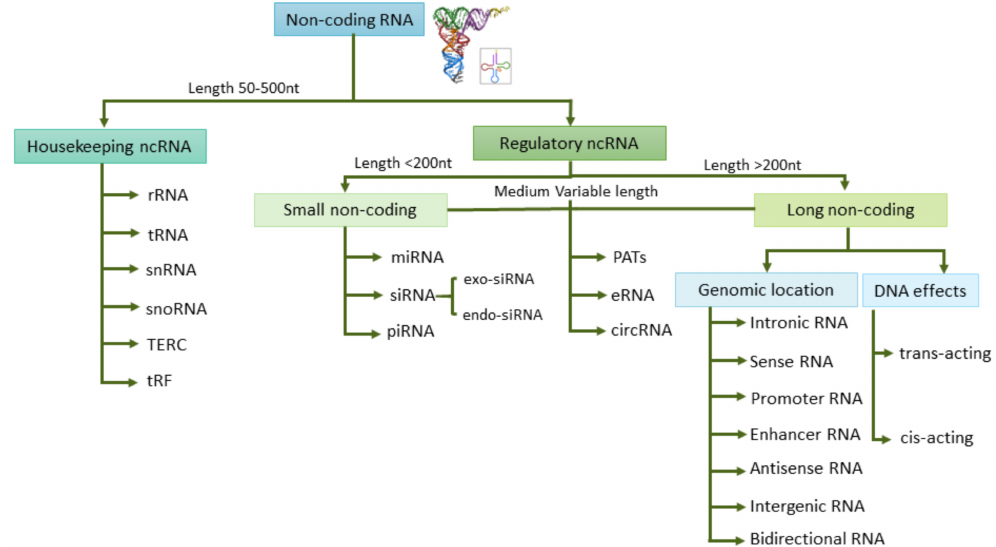
Figure 2. Non-coding (nc)RNAs classification into different groups based on their length and their regulatory roles. Small non coding RNA (sncRNA), long non coding RNA (lncRNA), ribosomal RNA (rRNA), transfer RNA (tRNA), small nuclear (snRNA), small nucleolar (snoRNA), telomerase RNA component (TERC), tRNA-Derived Fragments (tRF) and tRNA halves (tiRNA), microRNA (miRNA), small interfering RNA (siRNA), piwi-interacting RNA (piRNA), promoter-associated transcripts (PATs), enhancer RNA (eRNA), circular RNA (circRNA), and long non-coding RNA